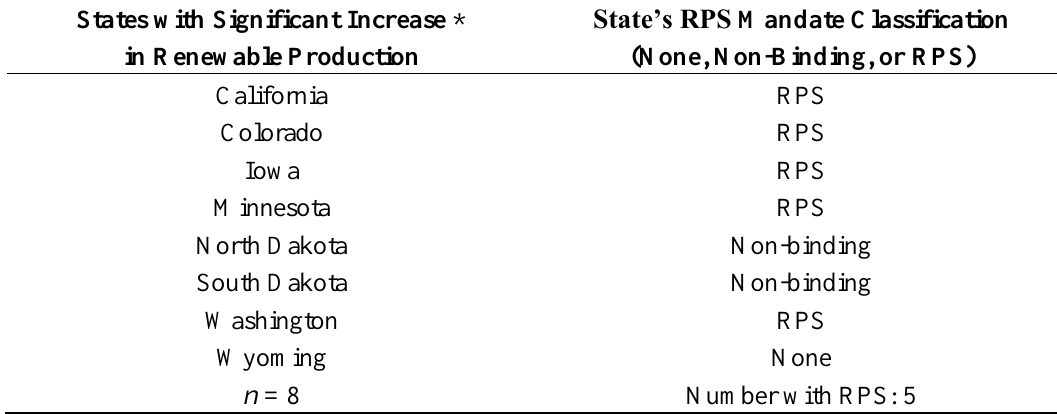
Table 3. State RPS mandates in states with increased percentage of renewable energy generation contributing to overall energy